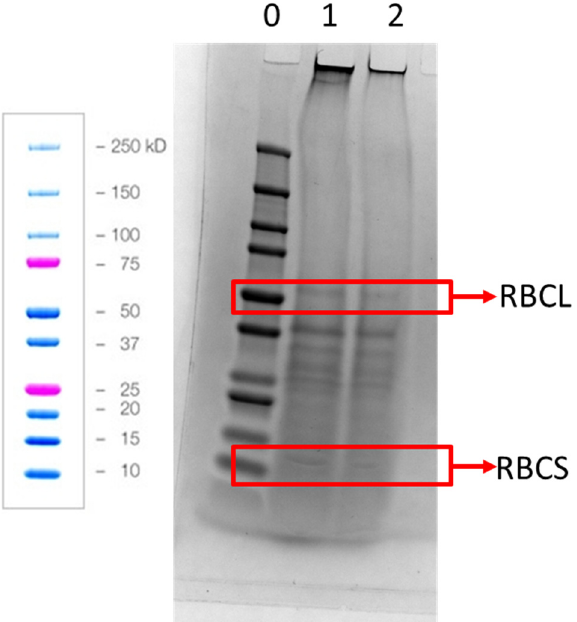
Figure 4. Reducing SDS-PAGE of the WS and WSS. Lane 0 = molecular weight standards, lane 1 = WS, lane 2 = WSS. RBCL = large RuBisCO subunit, RBCS = small RuBisCO subunit. Diagram on the left with blue and pink coloured bands is from Biorad’s instructions showing how the standards are expected to run. The same mass of WAPC was used to prepare the sample loaded into the wells.